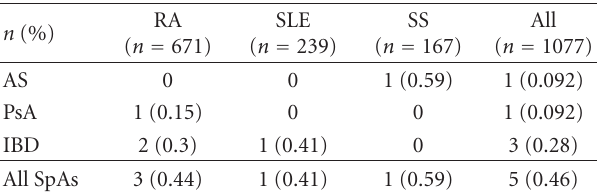
Table 6: Prevalence of SpAs in patients with